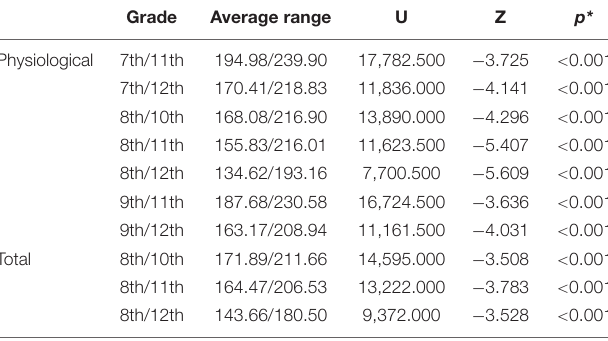
TABLE 5 | Comparison by grade, Mann–Whitney U with Bonferroni correction, of significant differences found in the degree of anxiety.